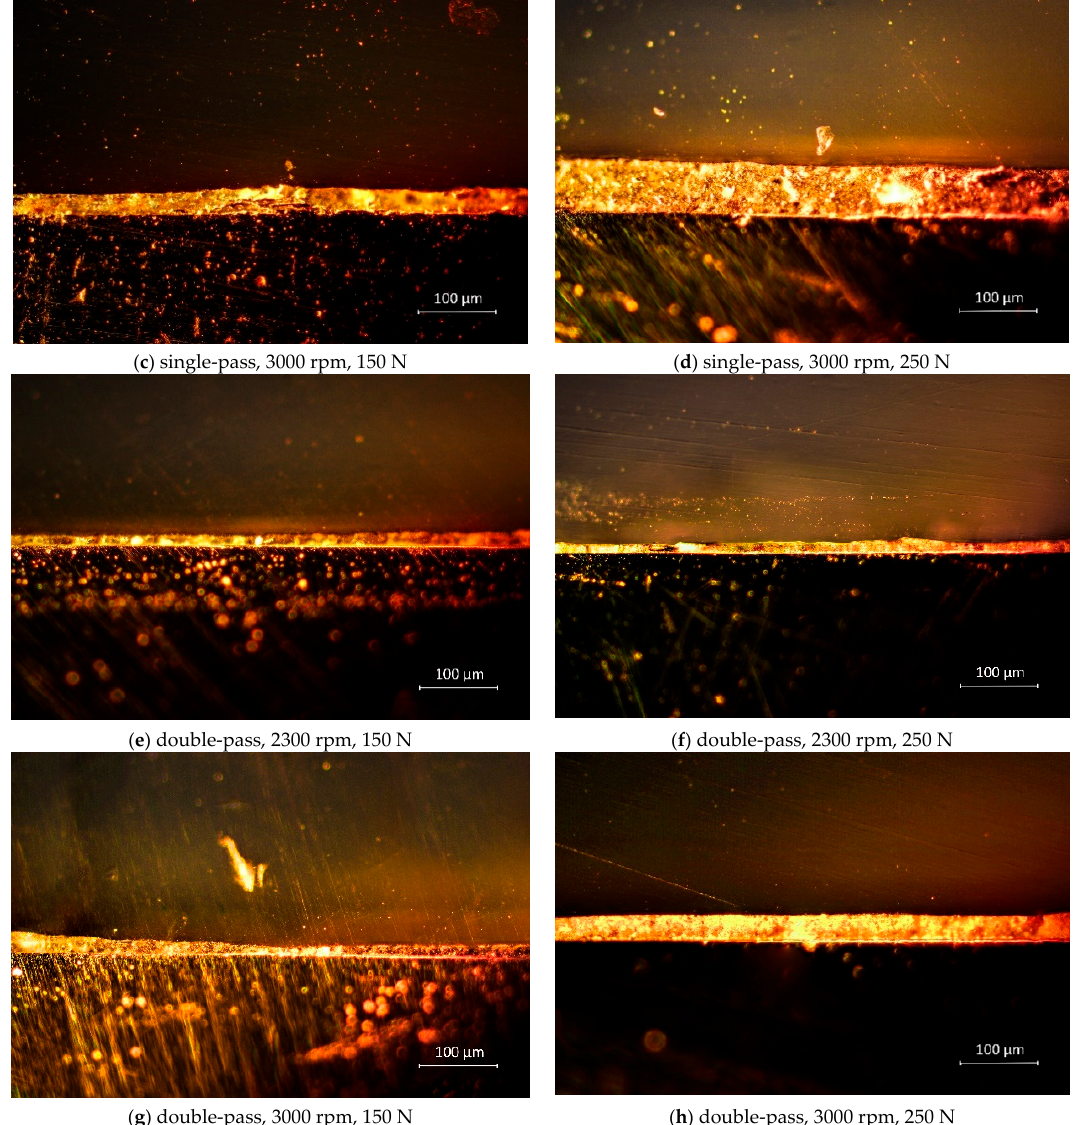
Figure 12. Optical microscope view of cross-sections of depositions using 20× magnification of a Leica DM2700.